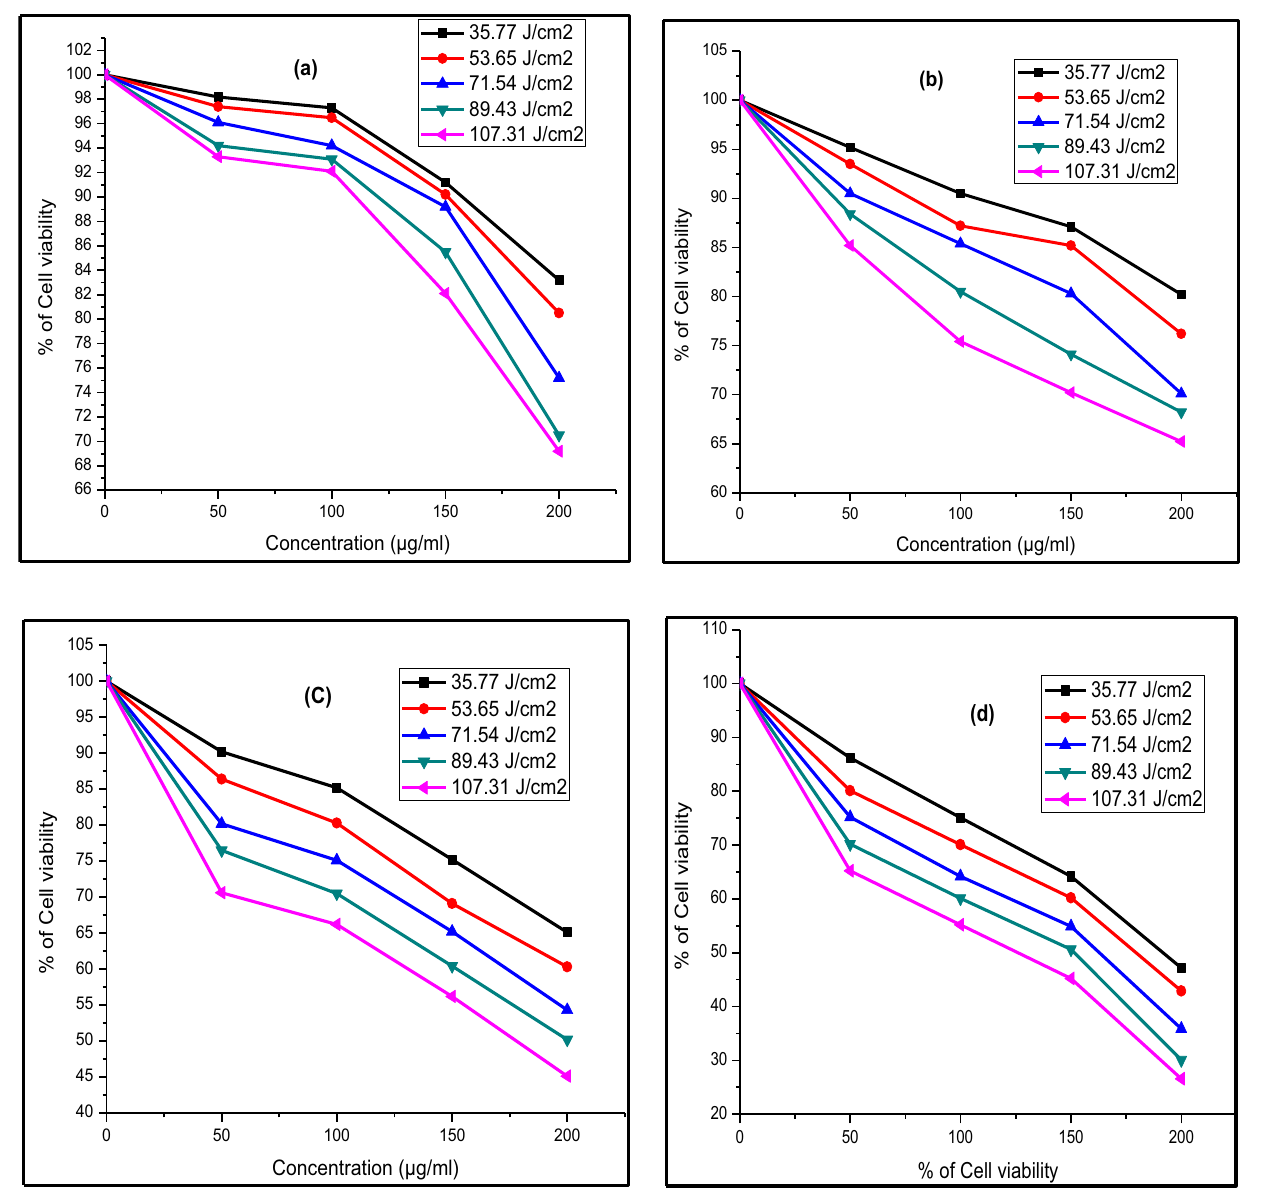
Figure 13. Cell viability of AS-CT nanocomposites on HeLa cells after ( a ) 8 h, ( b ) 12 h, ( c ) 16 h and ( d ) 24 h of